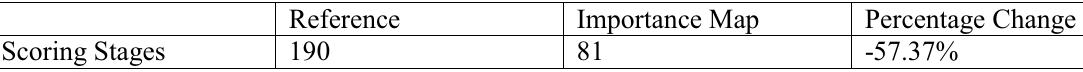
Table IV.: Percentage Change of Number of Used Scoring Stages before reaching 5% standard deviation for all fuel pins before and after the inclusion of an importance